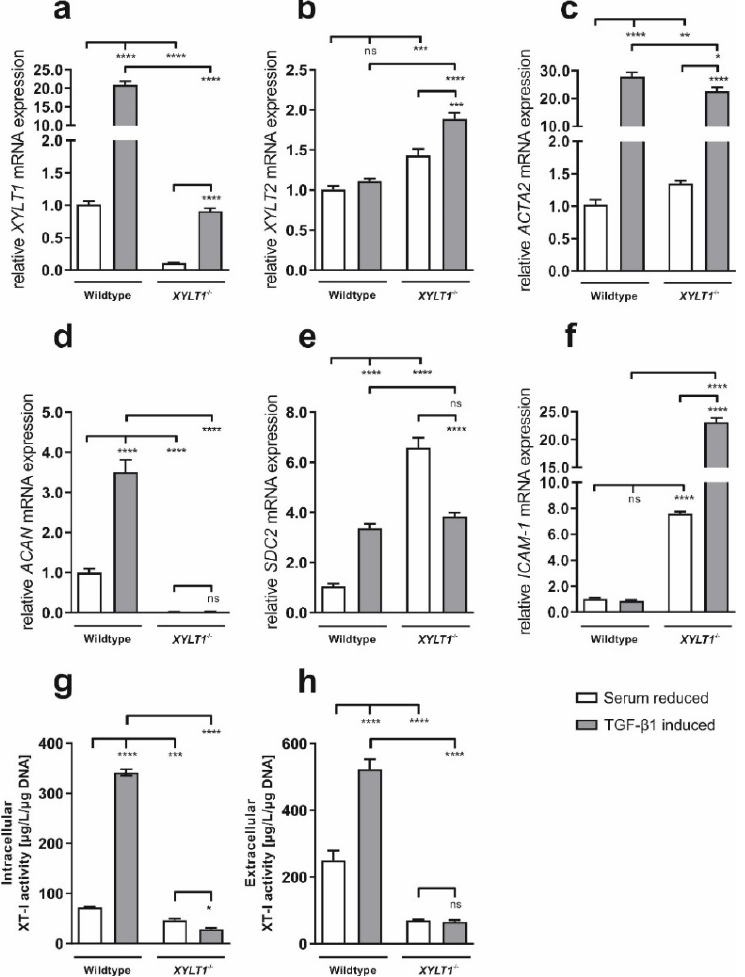
Figure 3. Relative mRNA expression levels of different ECM-related genes as well as intra- and extracellular XT-I activity after treating WT- and XYLT1 − / − fibroblasts with TGF- β 1. Wildtype and XYLT1 − / − fibroblasts were seeded (50 cells/mm 2 ) and incubated overnight. After 24 h, a serum withdrawal from 10% to 0.1% FCS was performed for 24 h. Thereafter, cells were incubated with vehicle (negative control) or TGF- β 1 (5 ng/mL). After an additional 48 h, the total RNA was isolated and reverse transcribed. cDNA was used to determine relative mRNA gene expression levels of XYLT1 ( a ), XYLT2 ( b ), ACTA2 ( c ), ACAN ( d ), SDC2 ( e ) and ICAM-1 ( f ) by real-time PCR. Data were normalized to a normalization factor, determined by calculating the geometric mean of HPRT , GAPDH and β 2M mRNA expression levels, and expressed as a ratio to one cell line. Intra- ( g ) and extracellular ( h ) XT-I activities were determined after a cultivation time of 72 h by